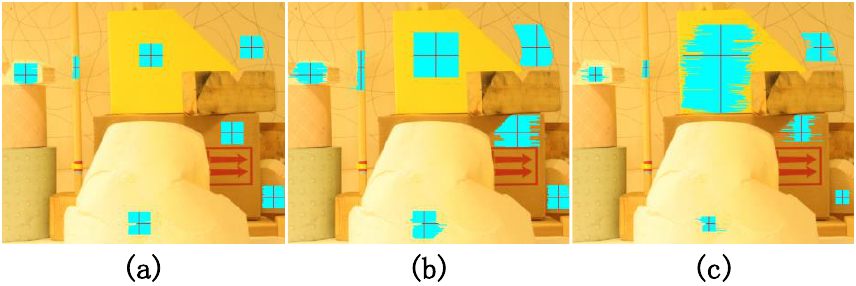
Figure 6. Examples of cross-based windows on the Lampshade1 image via various construction approaches. ( a ) Zhang et al. [19]; ( b ) Mei et al. [14]; ( c ) proposed construction approach.